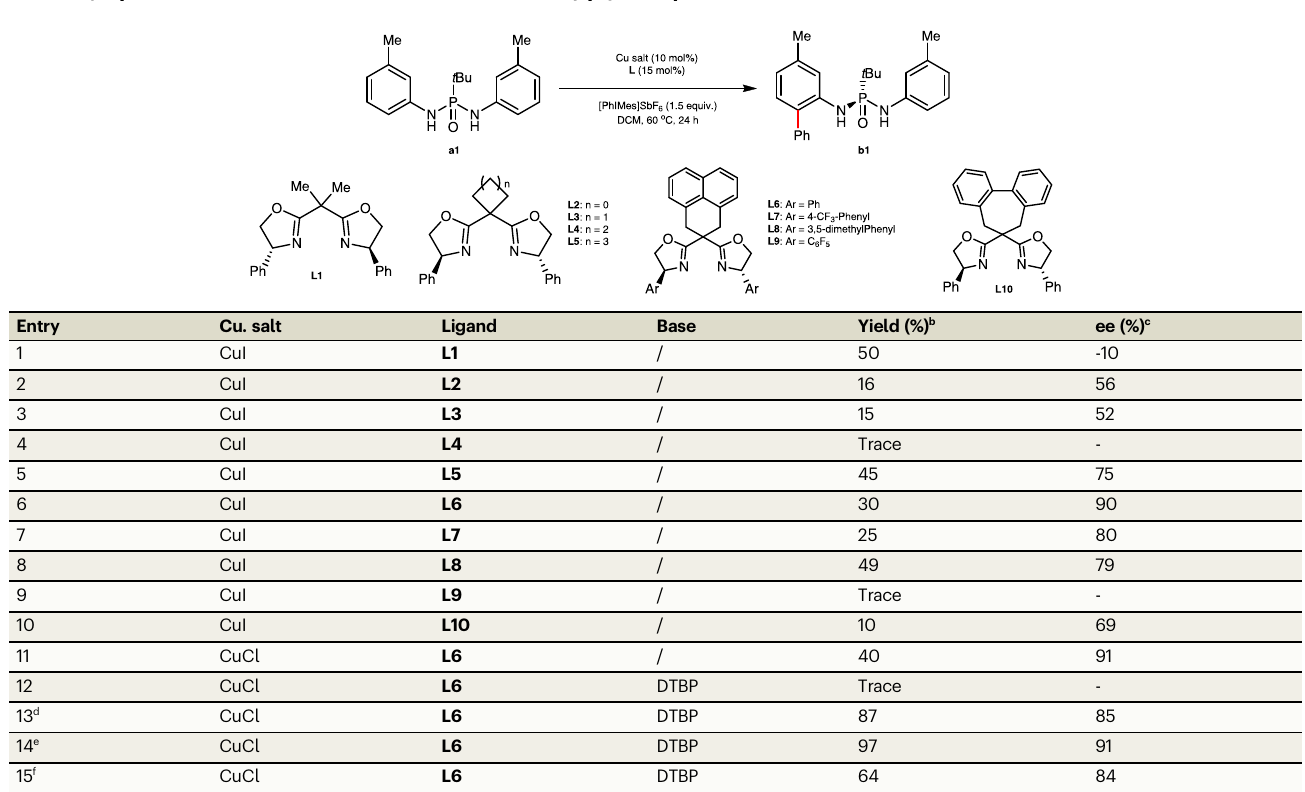
Table 1 | Optimization of the enantioselective o rtho -C(sp 2 ) – H arylation of a1 a